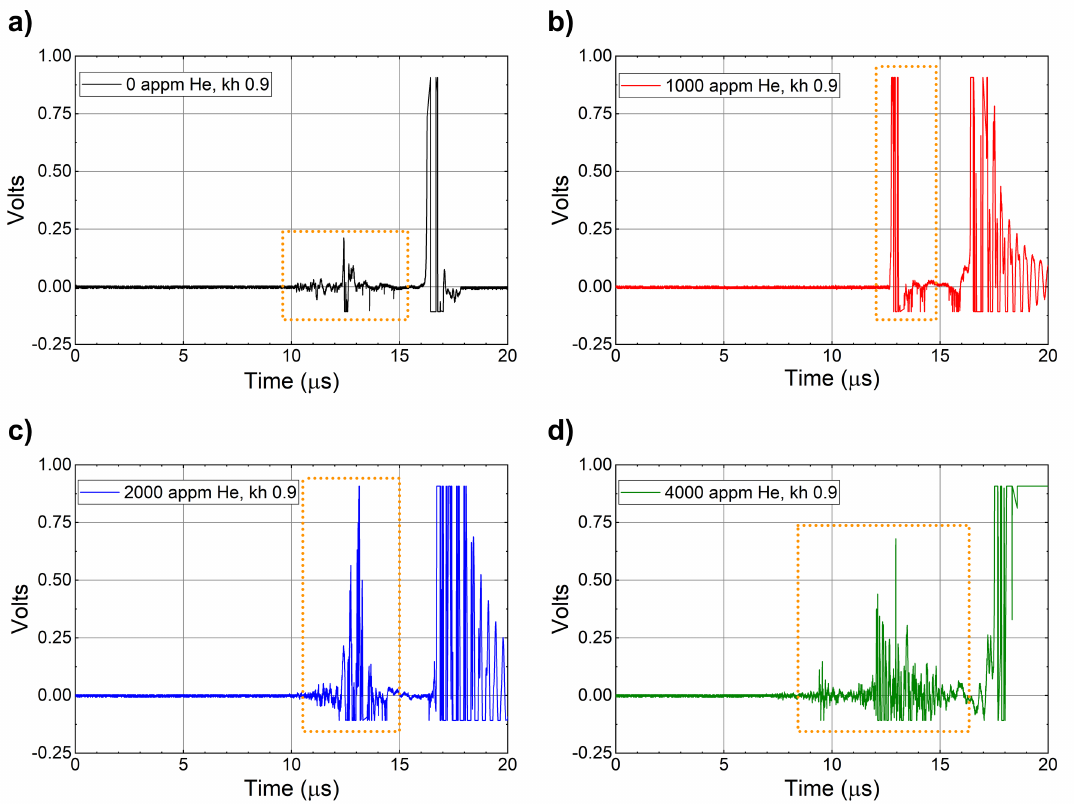
Figure 10. Voltage–time history corresponding to ( a ) 0 ppm, ( b ) 1000 ppm, ( c ) 2000 ppm, and ( d ) 4000 ppm for the four shots obtained from LN pins placed at a kh of 0.9. The dotted boxes outline the beginning and start times associated with ejecta at the LN pins. The late time signal is attributed to the free surface of the copper impacting the LN